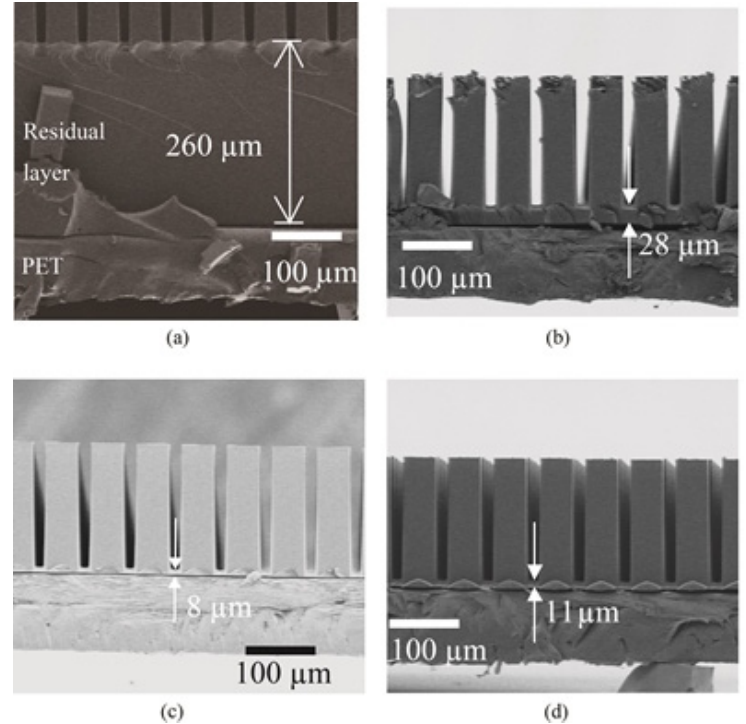
Figure 8. Cross-sectional SIM images of samples: ( a ) without pressing (with mold and resin simply in contact); with batch pressing at ( b ) F ( d ) with roll pressing.